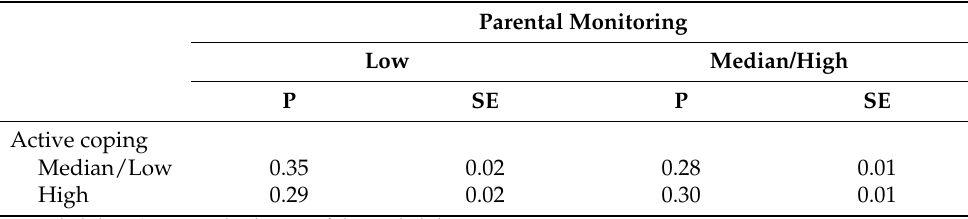
Table 3. Probabilities of alcohol use disorder predicted by the logistic regression (Model 1) across different levels of parental monitoring and active